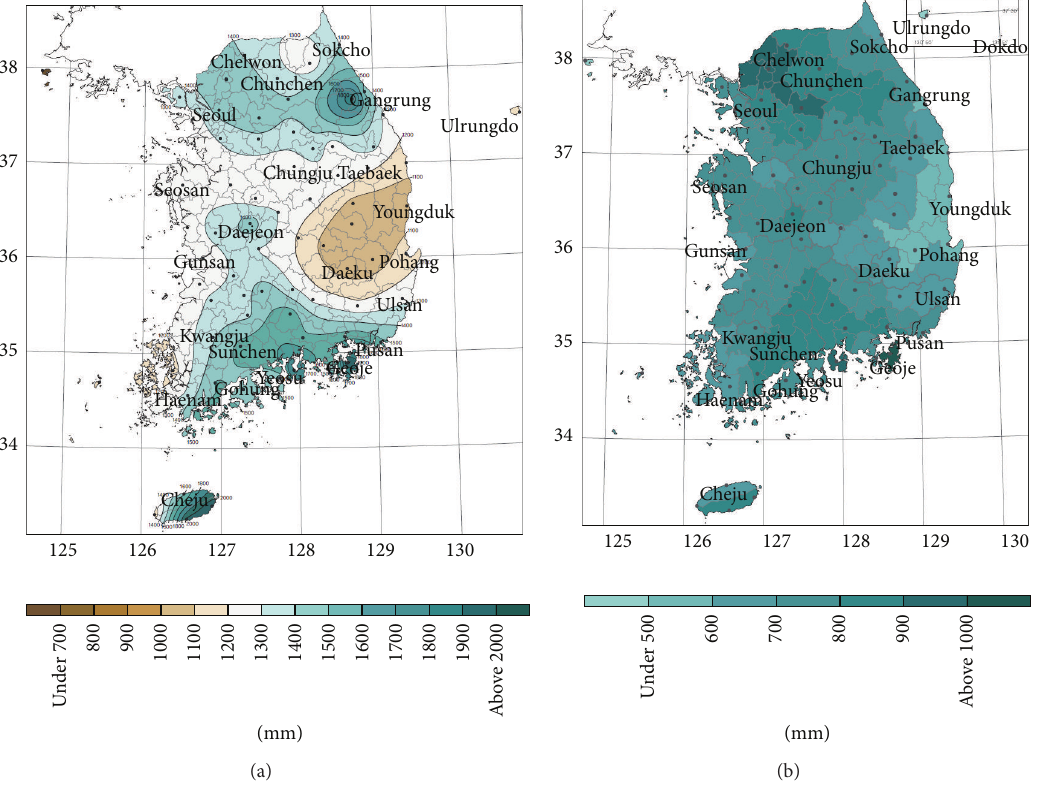
Figure 2: Annual (a) and summer (b) mean precipitation in South Korea (mm)